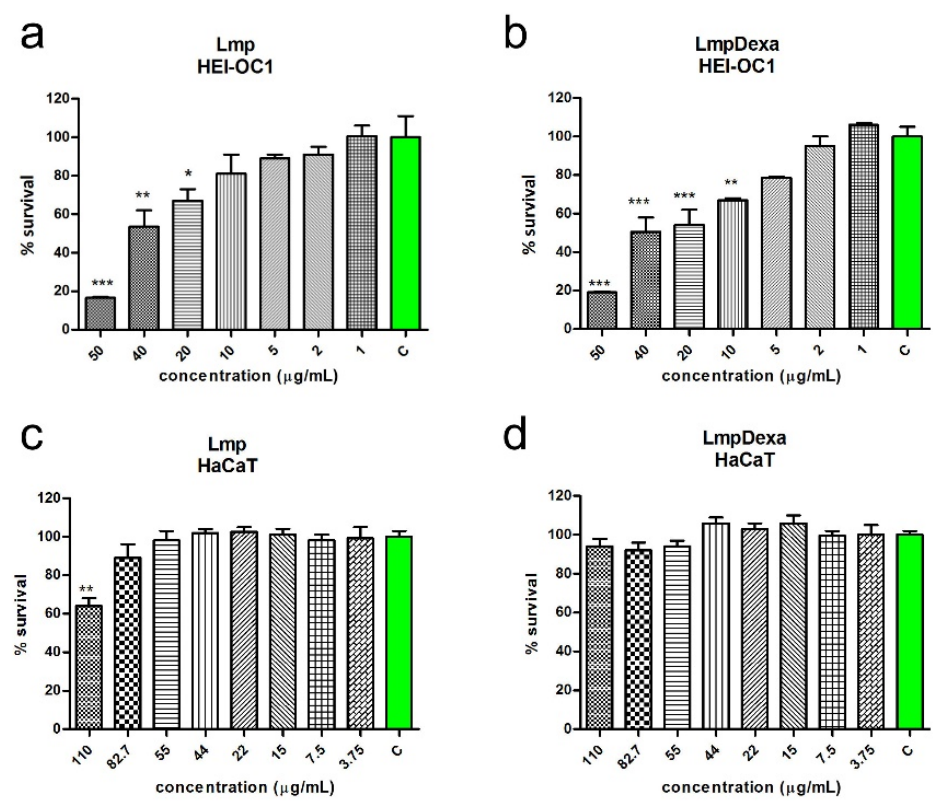
Figure 7. Concentration-dependent reduction of viability in HEI-OC1 and HaCaT cells after treatment with Lmp ( a , c ) and Lmp/Dexa ( b , d ) (*** p < 0.001; ** p < 0.01; * p < 0.5; one-way ANOVA, Dunnett’s multiple comparisons test).